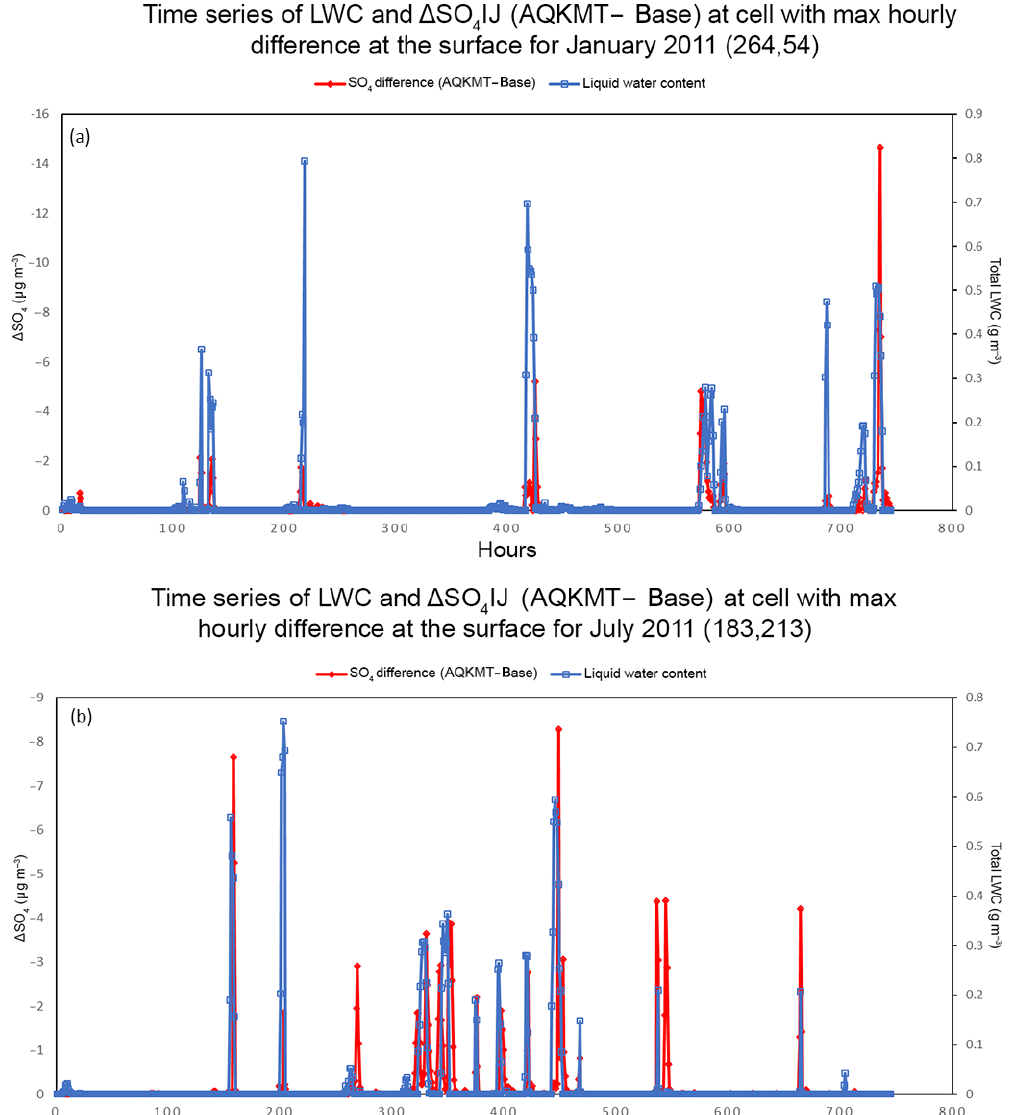
Figure 5. Modeled hourly liquid water content (blue, gm − 3 ) and change in fine SO 2 − the maximum (absolute) hourly difference for (a) January and (b) July